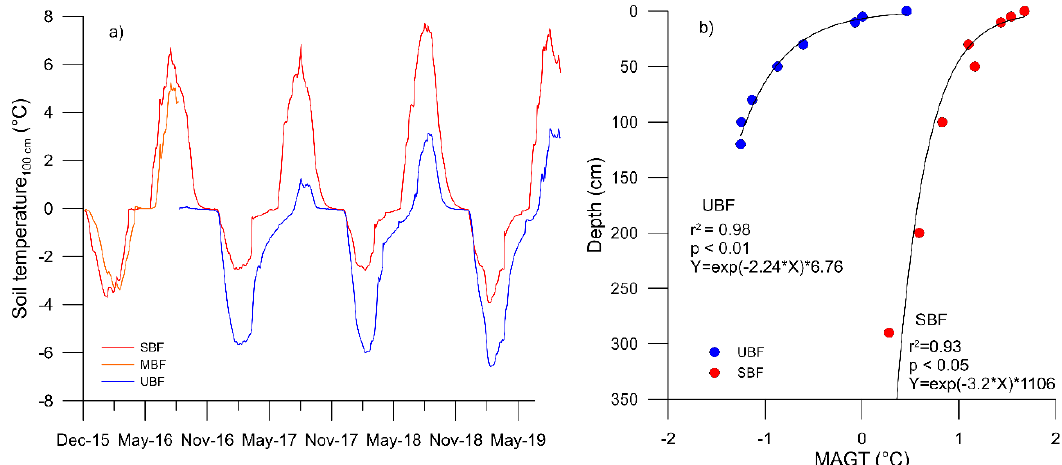
Figure 7. Observed daily ground temperature at 1-m depth under severely burned (SBF), moderate burned (MBF), and unburned (UBF) forests ( a ). Mean temperature profile at SBF compared to UBF ( b ).